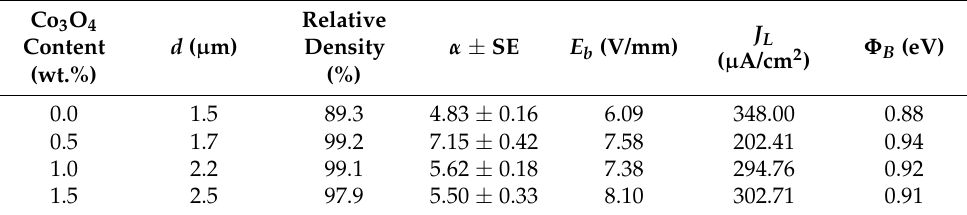
Table 6. Average grain size ( d ), Relative density, nonlinear coefficient ( α ), breakdown voltage ( E b ), leakage current density ( J L ), and Schottky barrier height ( Φ B ) of Co 3 O 4 at different